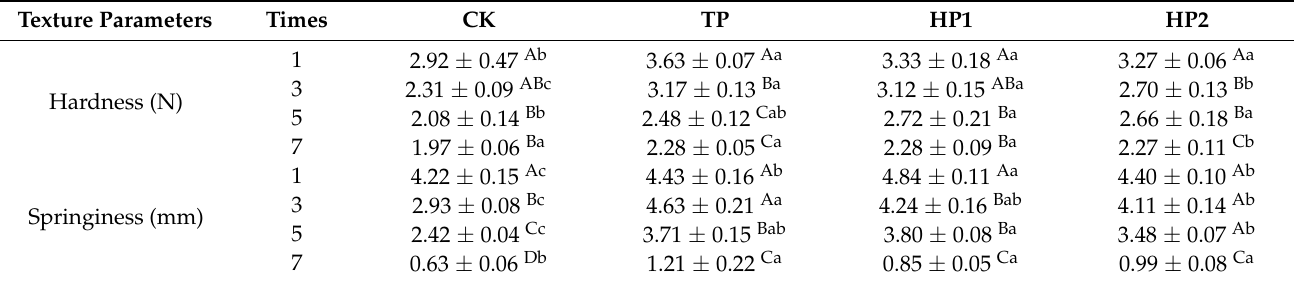
Table 1. Changes in texture parameters of freeze-thawed fish fillets.